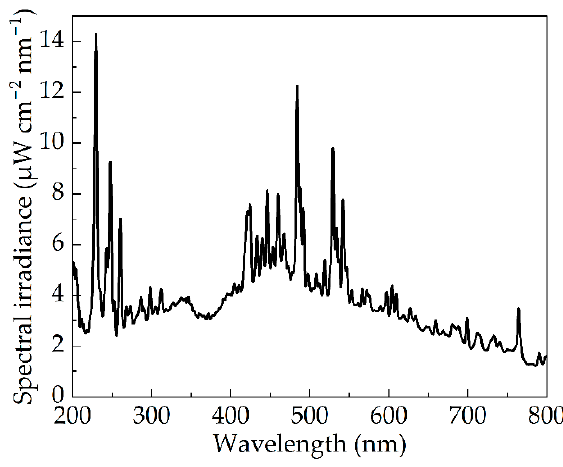
Figure 3. Instantaneous spectral distribution of pulsed xenon lamp. Table 2. Percentage of each band spectral irradiance in the UV–visible spectrum of pulsed xenon